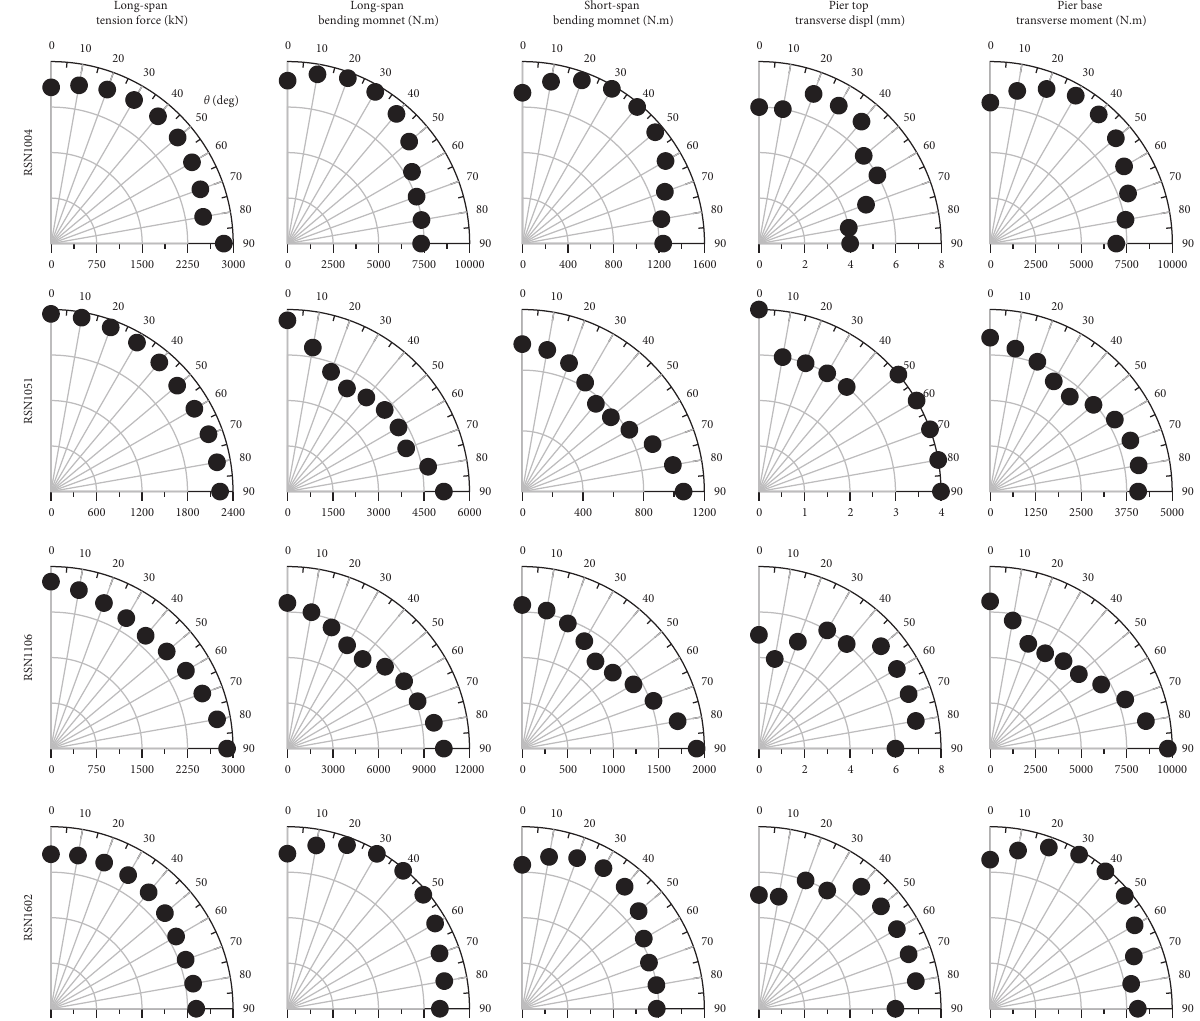
Figure 10: Distribution of responses obtained from pulse-type ground